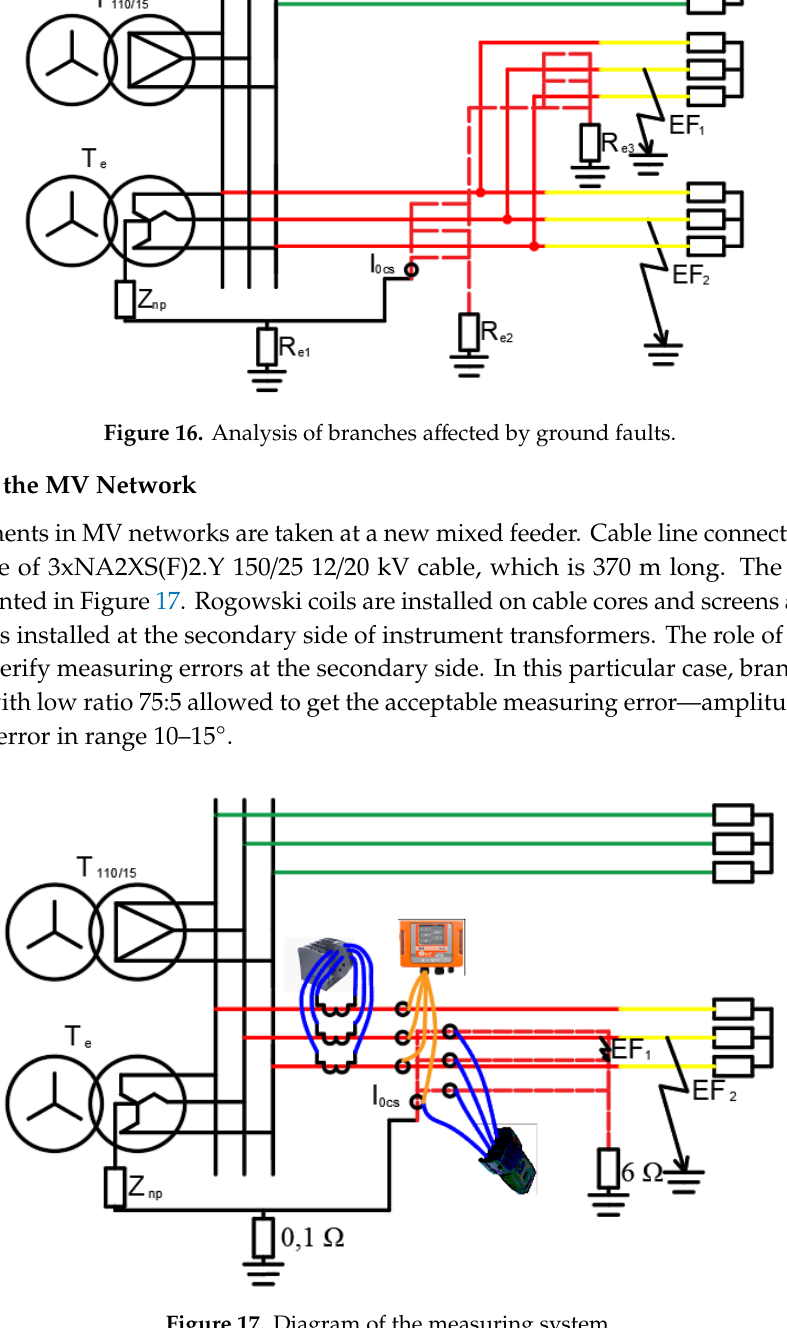
Figure 17. Diagram of the measuring system.